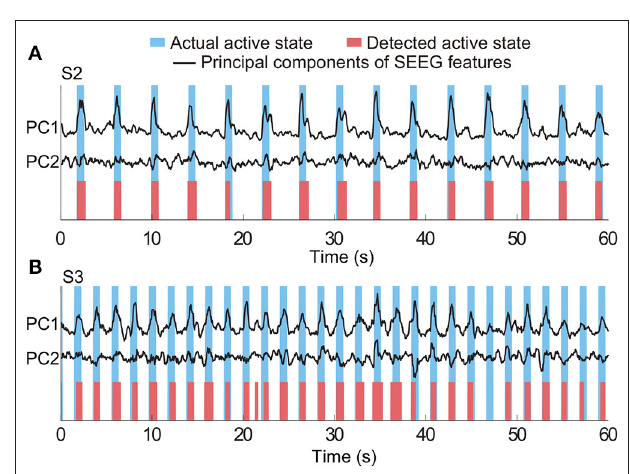
FIGURE 5 | Representative results of state detection. Light blue and red bars respectively indicate the actual active state and detected active state by the HMM classifier. Periods with white indicate the actual and detected idle states. Panels (A,B) are the results from two typical subjects (S2 and S3). There is no FN and FP detection in (A) , and there is one FN detection and one FP detection in (B)